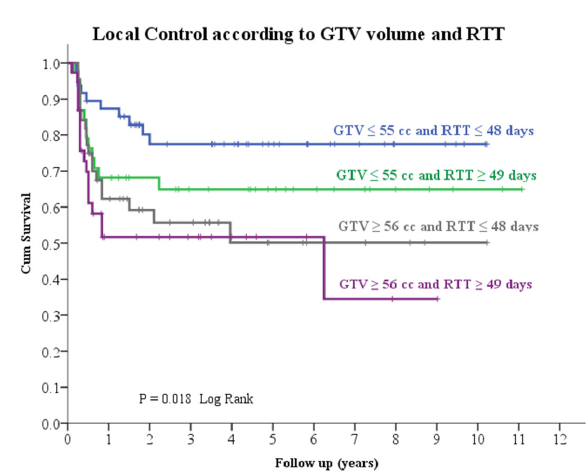
Fig. 2. Univariate Kaplan-Meier Analysis proved significantly increased overall survival according to gross tumour volume ≤ 55 cc and/or radiotherapy treatment time ≤ 48